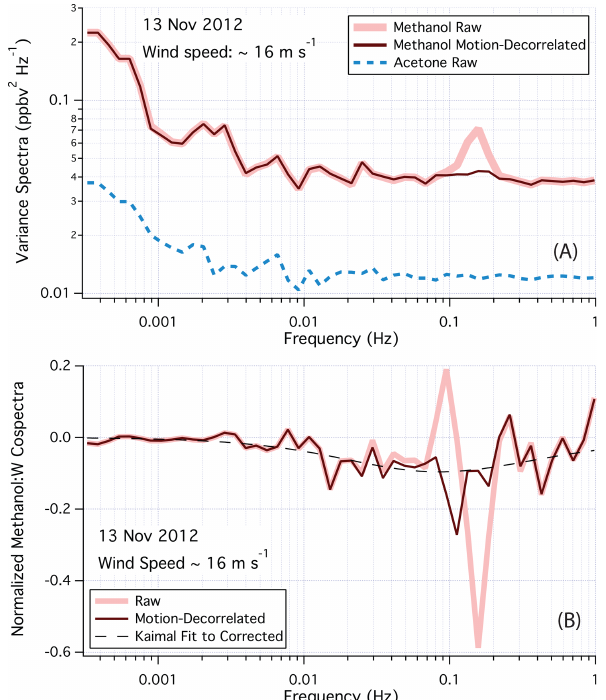
Figure A1. (A) Variance spectra of methanol (raw and motion- decorrelated) and acetone (raw) averaged over 10h on a day of very high winds and severe motion; (B) cospectra of methanol: w (raw and motion-decorrelated) on this date. Decorrelation effectively re- moves the artificial peak in the raw methanol variance spectrum at the frequency of ship’s motion (0.08–0.2Hz), while preserving the spectrum elsewhere. The corrected methanol cospectrum is reason- ably described by a Kaimal